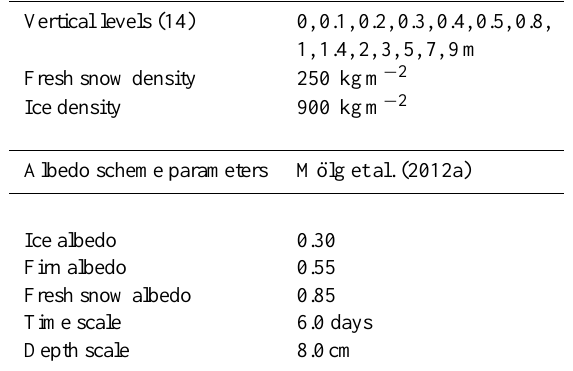
Table 2. MB model